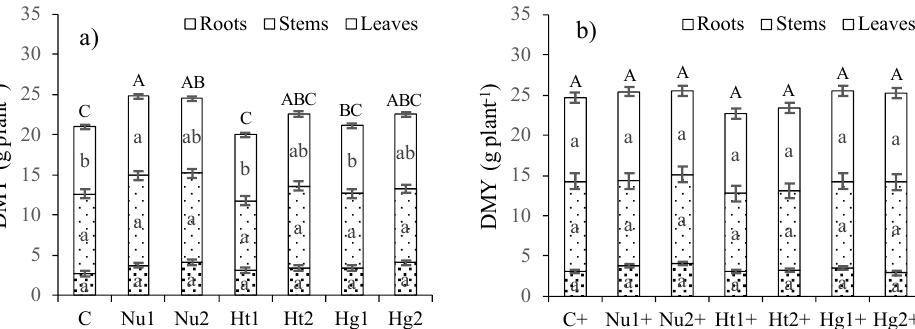
Figure 1. Dry matter yield (DMY) in roots, stems, leaves and total in response to the application of organic amendments (C, Control; Nu, Nutrimais; Ht, Humitec; and Hg, Humic gold, applied at two rates (1,2)) in experiments ( a ) without and ( b ) with NPK(+) mineral fertilization. Lowercase letters show the results of analysis of variance and means separation (Tukey HSD, α = 0.05) for each plant part and uppercase letters for total DMY.